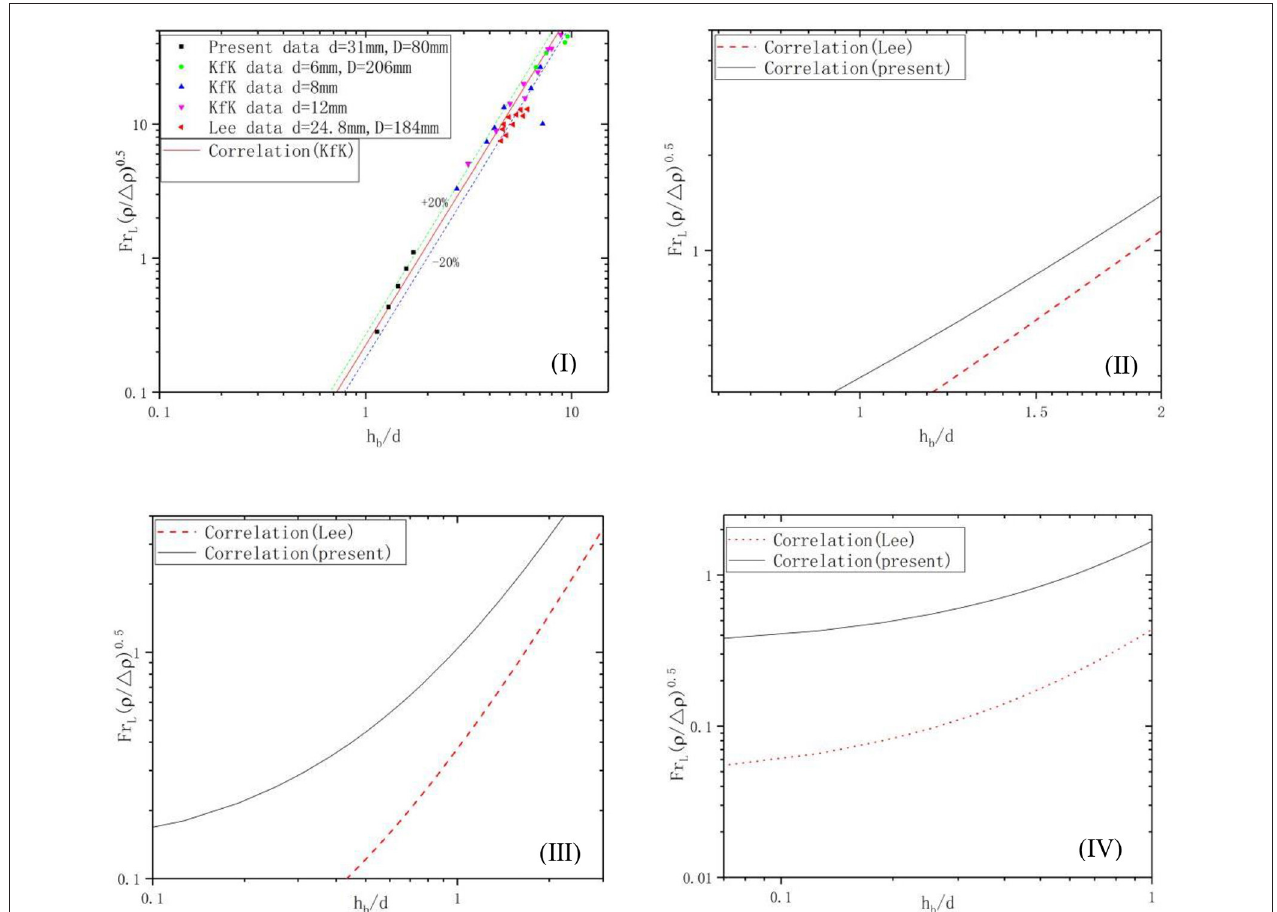
FIGURE 4 | Comparison of present data correlation and KfK and Lee correlations, (I) θ = − 90 ◦ , (II) θ = − 60 ◦ , (III) θ = − 45 ◦ , and (IV) θ = − 30 ◦ .